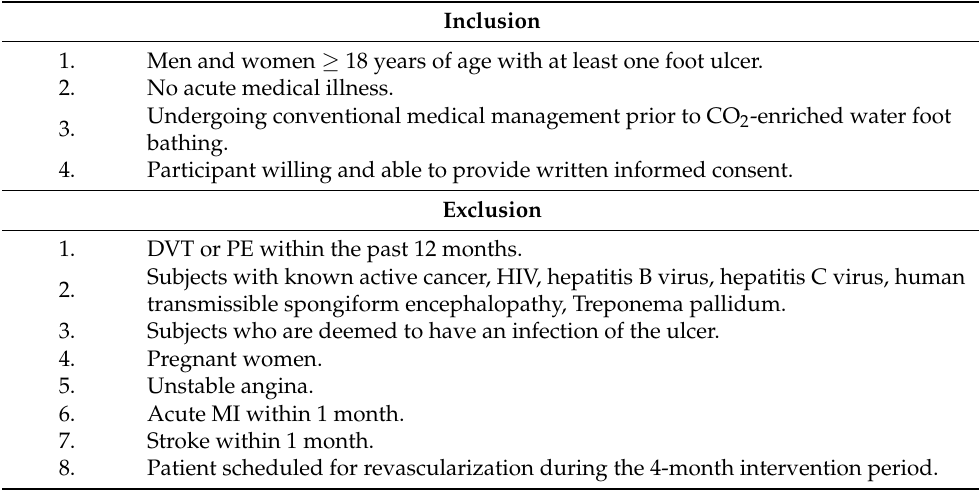
Table 1. Criteria used for inclusion and exclusion for the